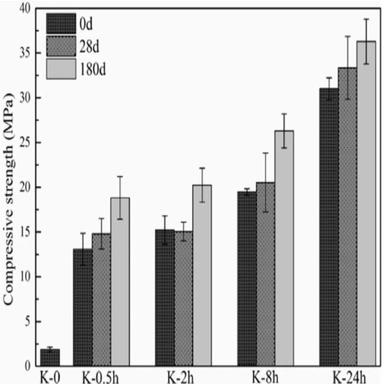
The compressive strength of BOFS compacts after accelerated carbonation and subsequent hydration (carbonation time: 0–24 h, and subsequent hydration: 0–180 d).